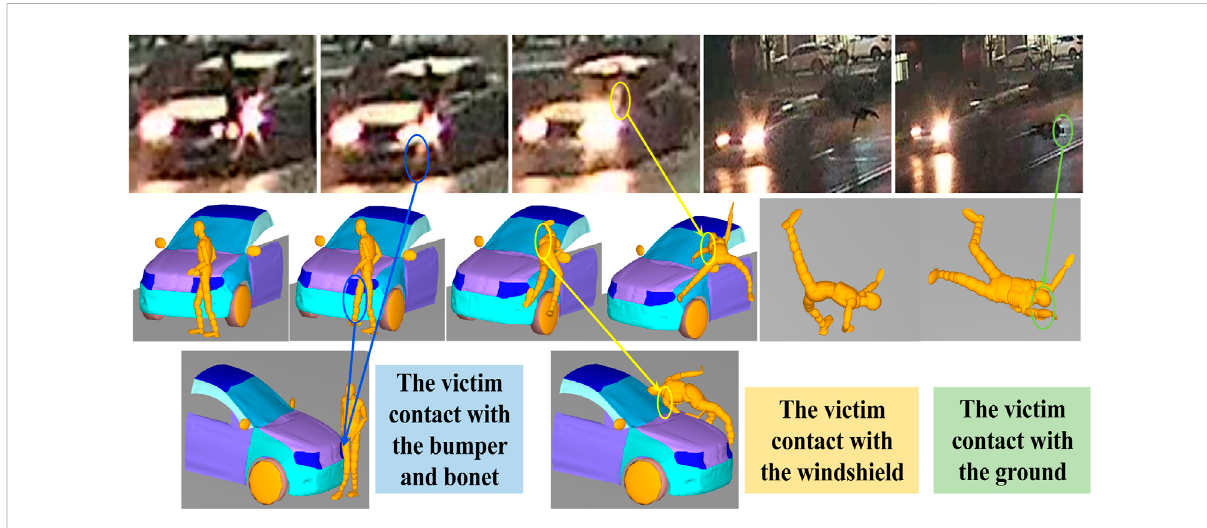
FIGURE 6 Comparison ofkinematicresponsebetweensimulationandaccident(informedconsentwasobtainedfromthefamiliesofthedeceasedforthe relevant content in this fi gure).